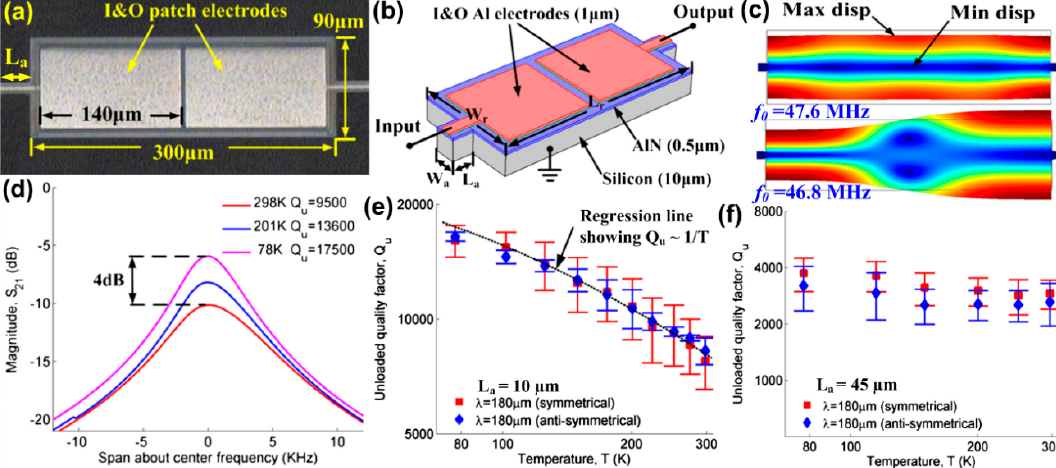
Figure 6. Experimental investigation of thermoelastic damping (TED) using cryogenic cooling: ( a ) optical micrograph of a rectangular Al-on-Si LVR with supporting tethers (length is L a ) at two sides; ( b ) schematic of the resonator structure showing constituent layers; ( c ) simulated symmetrical and anti-symmetrical vibration modes at 47.6 MHz and 46.8 MHz, respectively; ( d ) measured electrical transmission magnitudes ( S 21 ) for the symmetrical mode as the device is cooled from room temperature to 78 K; ( e ) mean values and standard deviations of measured Q for the resonator with L a = 10 µ m when cooled from 300 K to 78 K; ( f ) mean values of measured Q for the resonator with L a = 45 µ m when cooled from 300 K to 78 K. This figure is reproduced from [52] (© 2016 Elsevier).